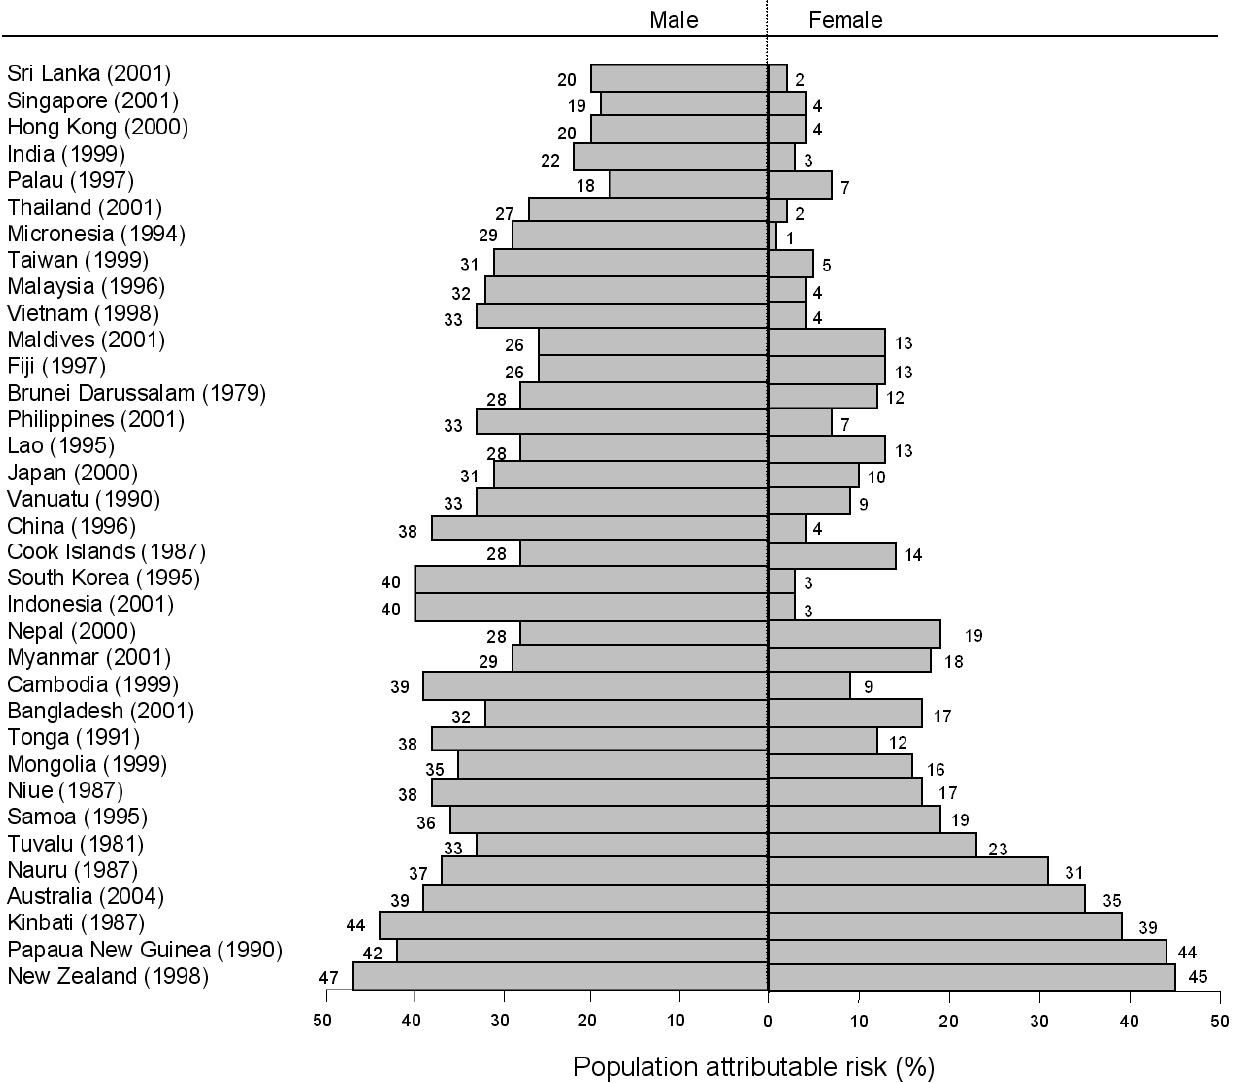
Figure 3. Population attributable risk (%) of upper aero digestive tract cancer for smoking. Data are derived from representative surveys (years of studies given in